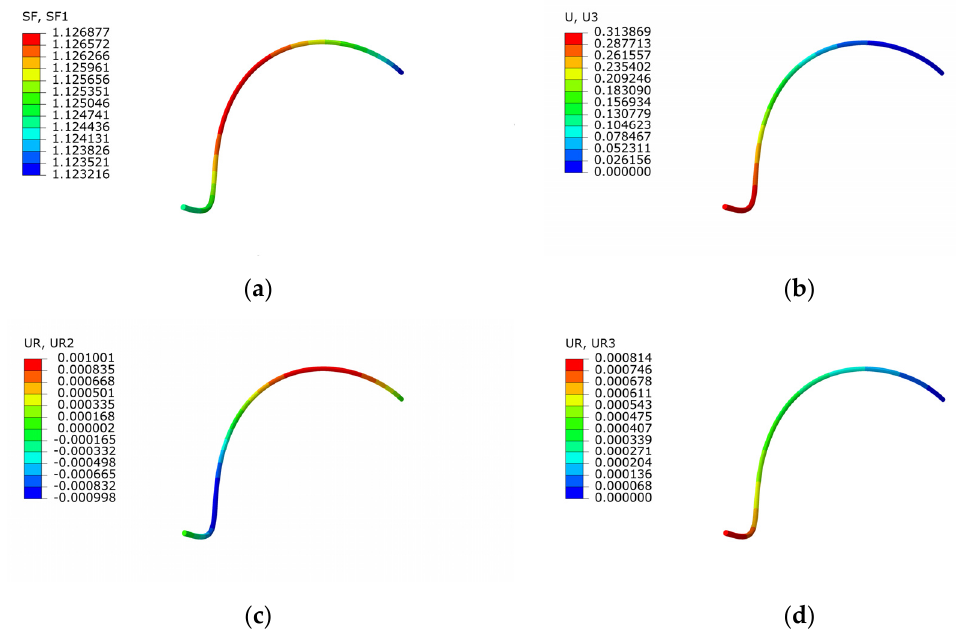
Figure 6. Finite element cloud map. ( a ) Axial tension, ( b ) stretch, ( c ) bending, ( d ) torsion.